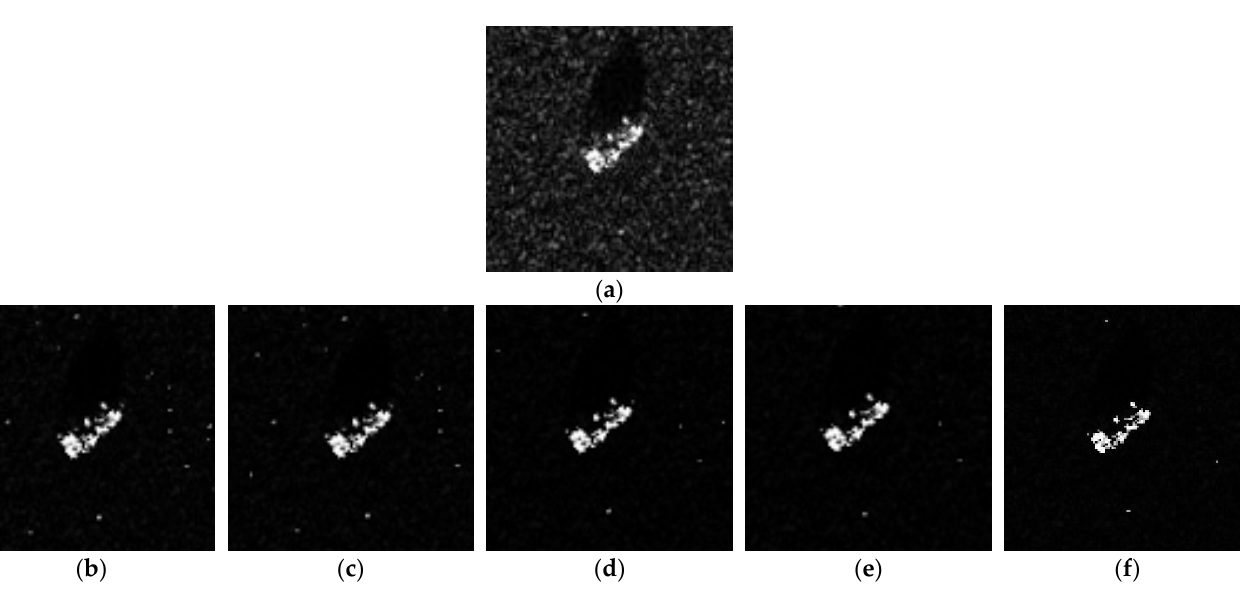
Figure 10. Weaken fusion result ( a ) BTR60 original; ( b ) the fusion ratio is 1:5; ( c ) the fusion ratio is 1:10; ( d ) the fusion ratio is 1:15; ( e ) the fusion ratio is 1:20; ( f ) the fusion ratio is 1:25. The testing dataset is created by selecting a sample from the MSTAR dataset. The Table 1. The samples dataset of the